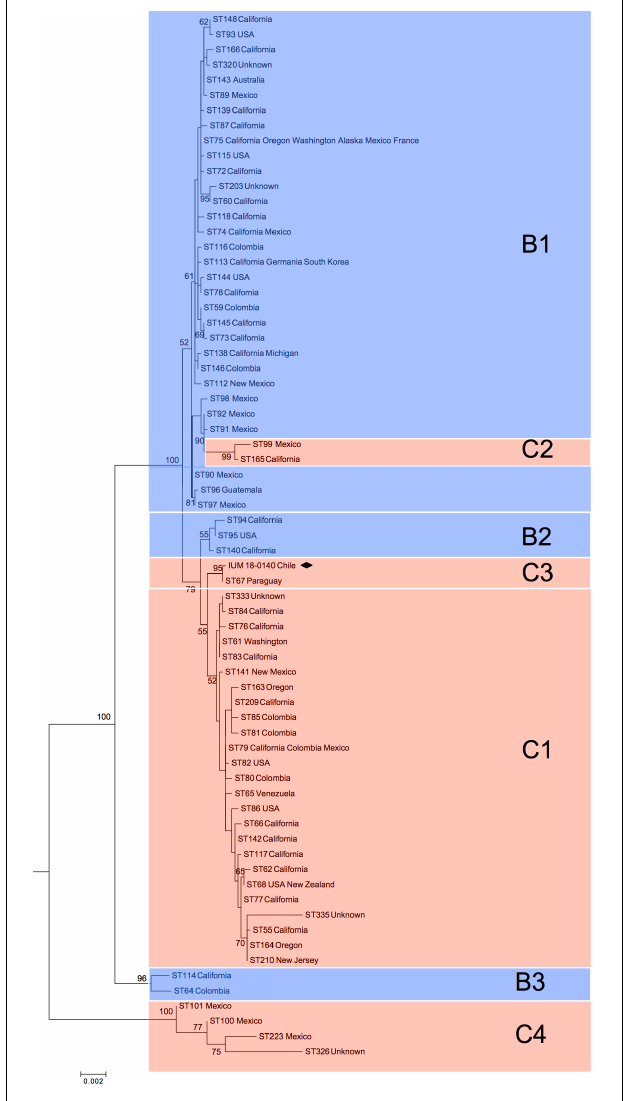
FIGURE 1 | Phylogenetic reconstruction by maximum likelihood method resulting from the comparison of the Chilean isolate (black square) with 69 global Cryptococcus bacillisporus (VGIII) STs. C1, C2, C3, and C4 identify clusters including serotype C strains, while B1, B2, and B3 identify clusters including serotype B strains. Results of bootstrap analysis ( > 50%) are indicated beside each